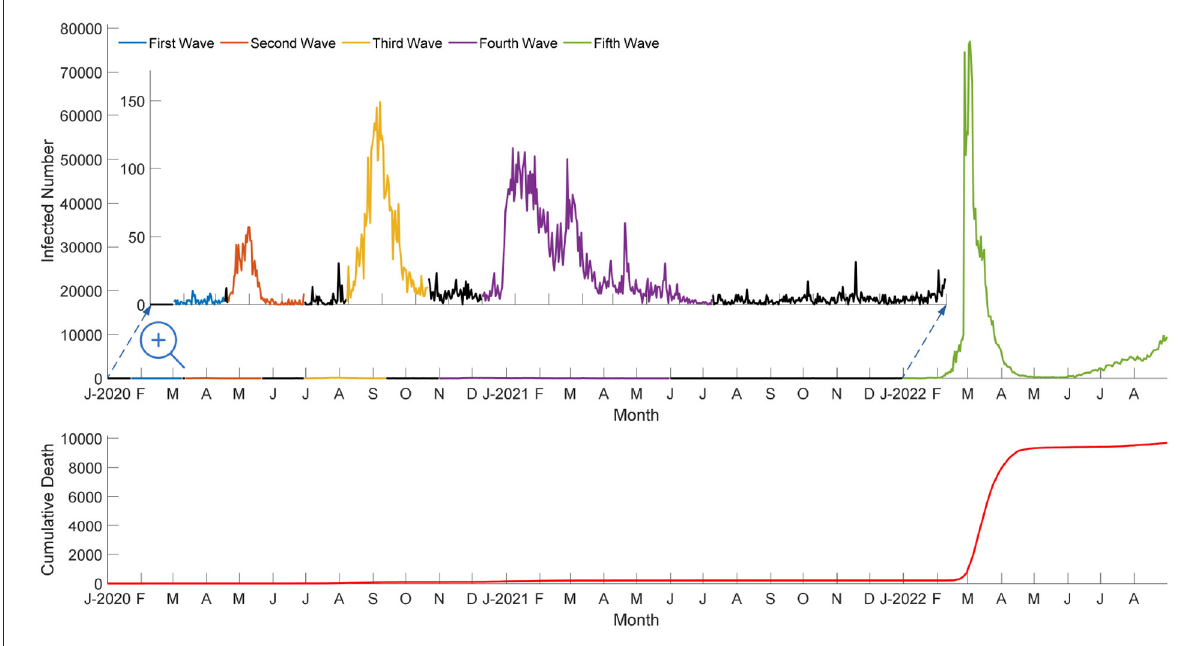
FIGURE1 Number of infected and death cases during the multiple waves in Hong Kong from 2020 to 2022.